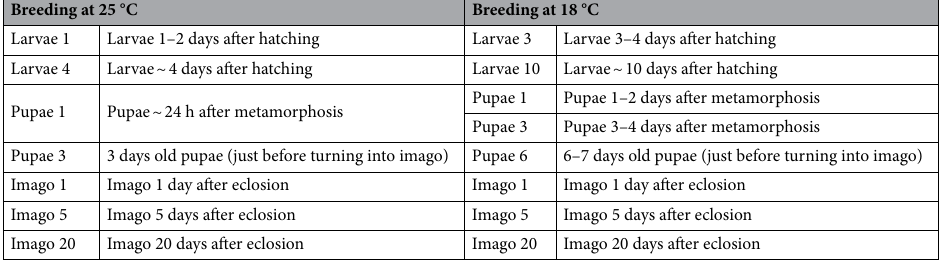
Table 1. Characteristics of the studied